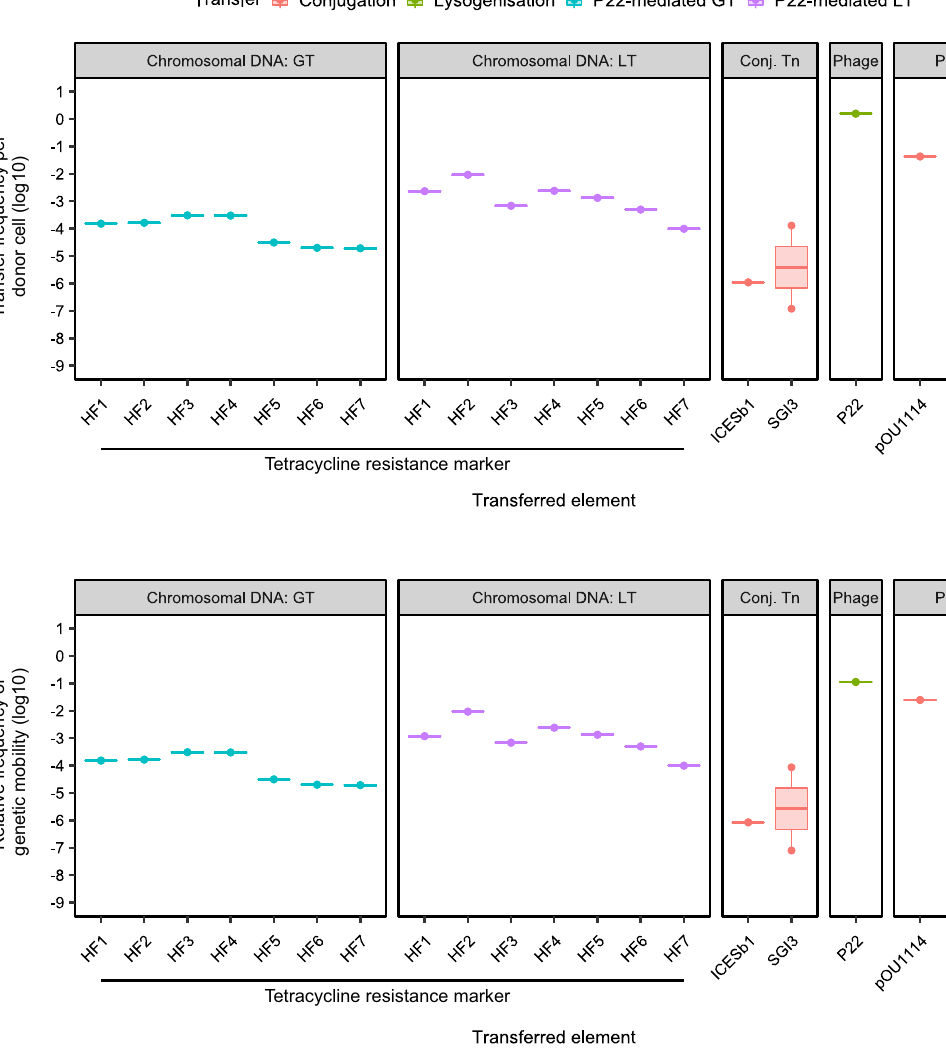
Fig. 3 Genetic mobility via different mechanisms in Salmonella spp. a Transfer frequencies per donor cell and b relative frequency of genetic mobility (de fi ned as transfer frequency × cargo capacity) of different genetic elements by transfer type. Transfer of chromosomal DNA by phage P22 via generalised (GT) or lateral (LT) transduction of a tetracycline resistance marker located at de fi ned distances from the phage attachment site, conjugative transposons (Conj. Tn), phages and plasmids. Data were extracted from literature or acquired through experimentation (see Table 3